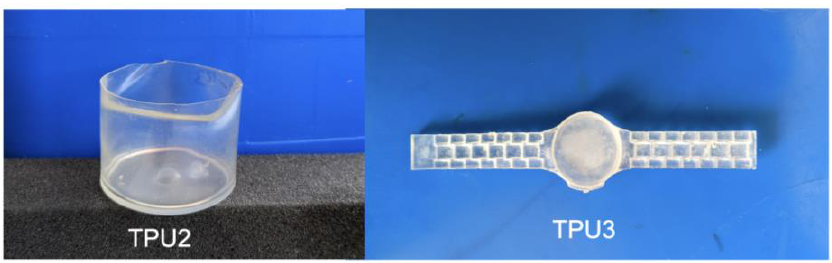
Figure 1. Photographs of bio-based TPUs (TPU2—a cup; TPU3—a hand watch). The synthesized TPUs contained up to 85% bio-carbon content. The calculation